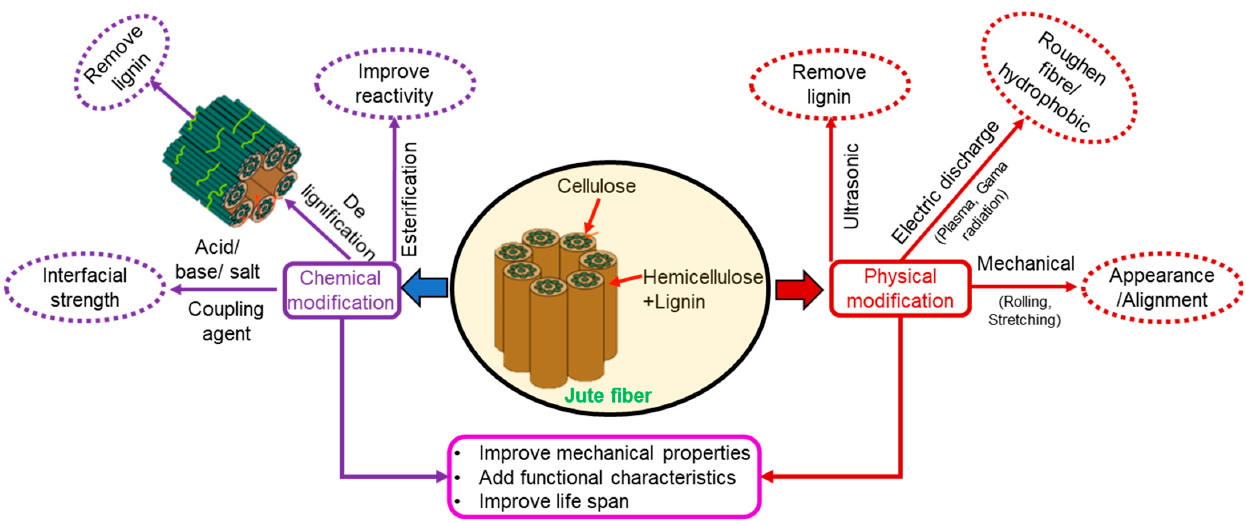
Figure 8. Types of treatments on jute fiber and their effects on fiber performance